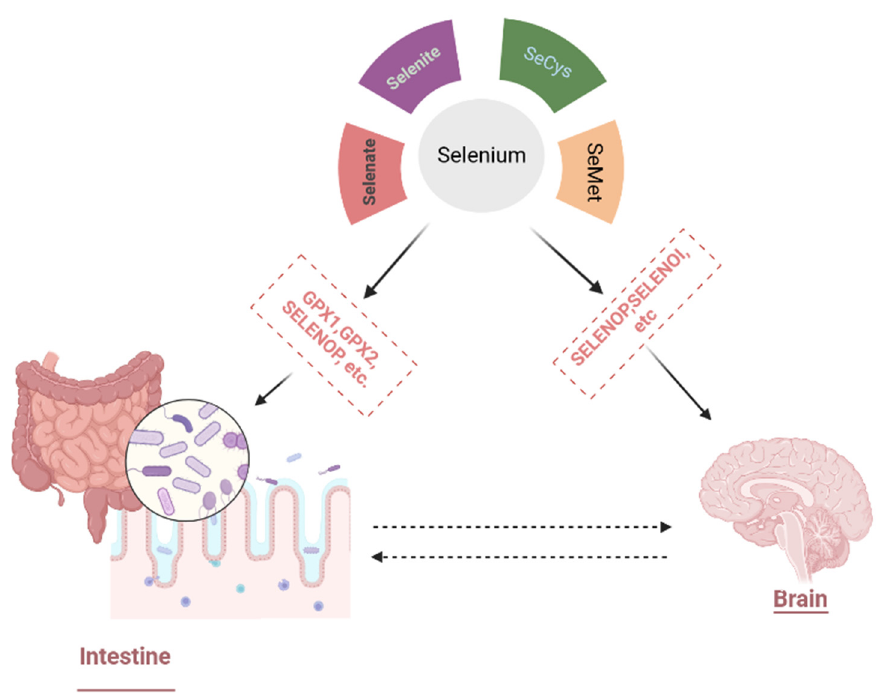
Figure 1. Different selenoproteins regulate different organs in the body. Se is mainly absorbed in the form of selenoproteins. GPX1 and GPX2 maintain the body’s health by regulating the production of reactive oxygen species (ROS). SELENOP normally acts as a plasma transporter in numerous organs, while DIO1 affects thyroid hormone activity. SELENOI, on the other hand, is involved in managing the nervous system, and a deficiency of SELENOI results in the emergence of neurodegenerative diseases.